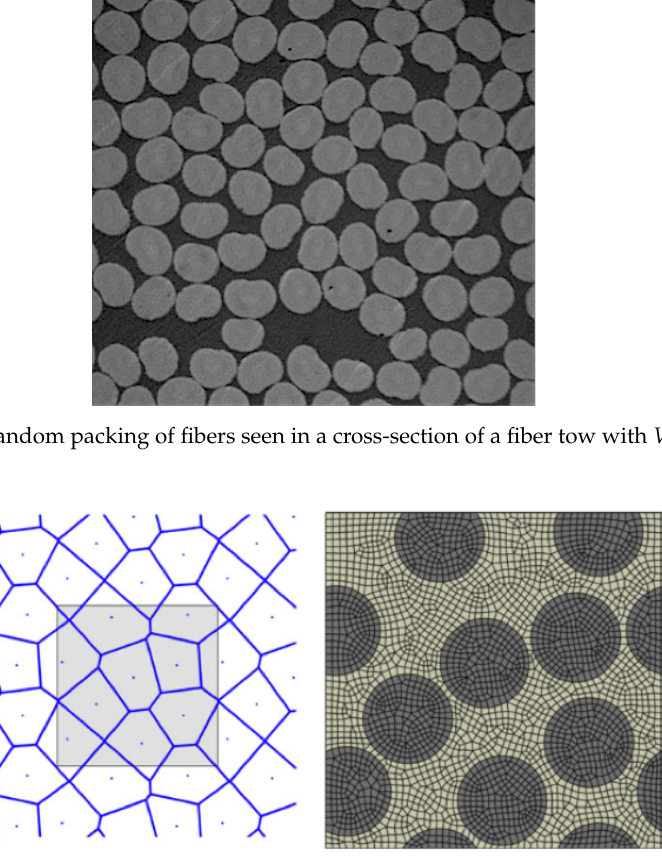
Figure 3. Voronoi cells and generated finite element model (Heinrich et al.